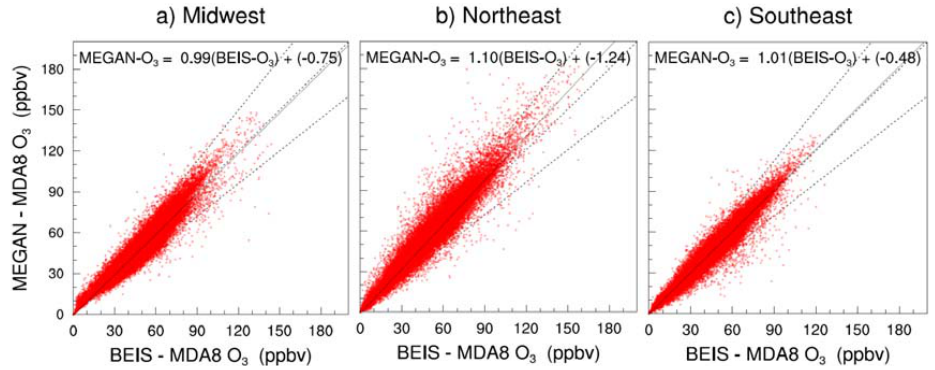
Fig. 6. Scatter plots of MEGAN2-MDA8 ozone versus BEIS3-MDA8 ozone for the months of May–September in the year 2000 on: (a) Midwest, (b) Northeast, and (c) Southeast.